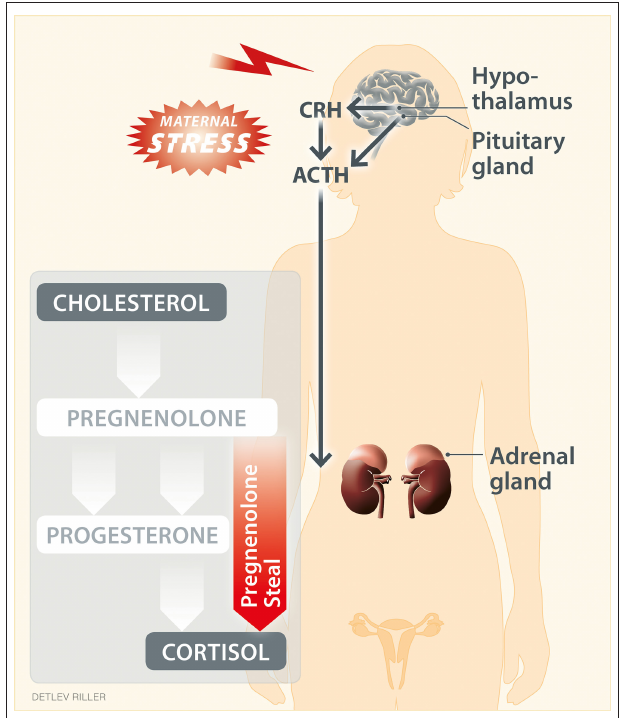
FIGURE 1 | “Pregnenolone steal” or how high stress perception may drive the depletion of progesterone. High stress perception activates the hypothalamic–pituitary–adrenal axis, resulting in the respective secretion of corticotropin-releasing hormone (CRH), adrenocorticotropic hormone (ACTH) and cortisol, the main glucocorticoid in humans. Moreover, stress can affect steroidogenesis in peripheral tissues. Steroidogenesis refers to the transformation of cholesterol into steroid hormones through a serious of steps. Here, the intermediate pregnenolone is a precursor of most steroid hormones, including progesterone and cortisol. Upon stress, the elevated synthesis of cortisol may reduce (“steal”) the pregnenolone available for the synthesis of down-stream hormones other than cortisol. This hypothetical scenario provides an explanation for the impaired progesterone production in response to